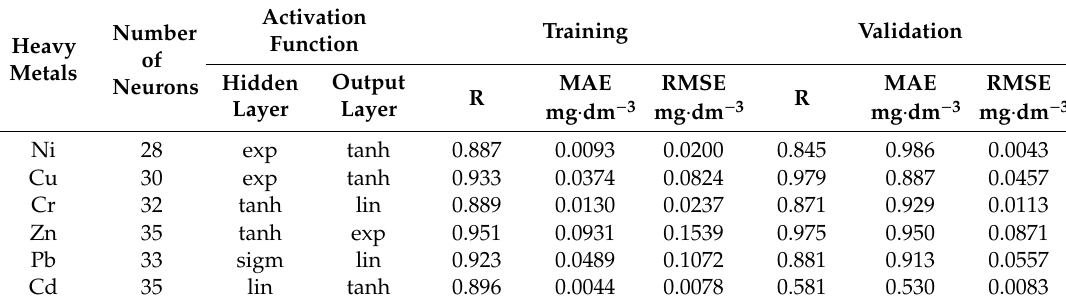
Table 5. Parameters of ANN structure and model fit to experimental